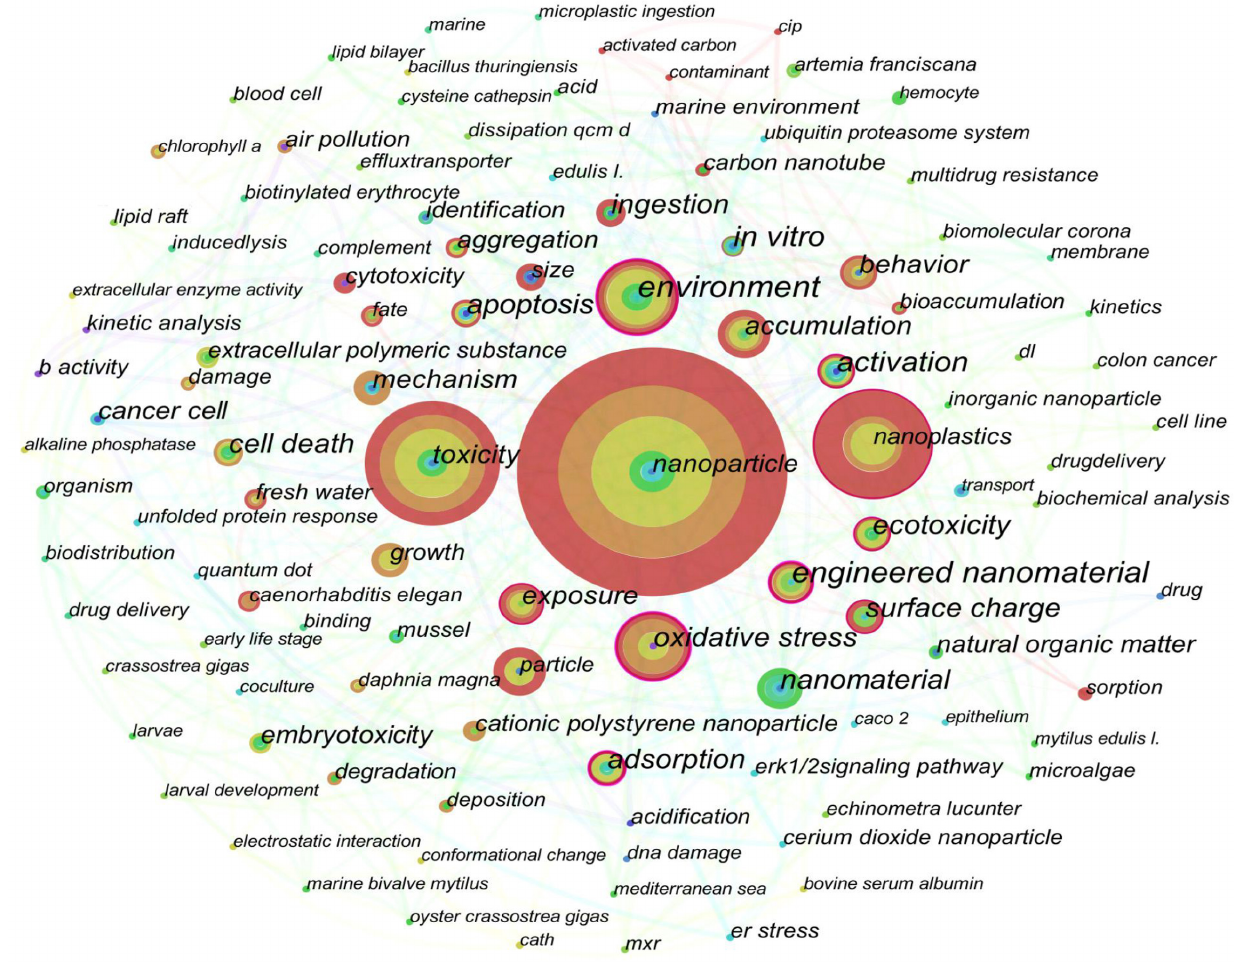
FIGURE 2 | Co-occurrence network of keywords extracted from the obtained literature. The size of each node represents the occurrence frequency of the corresponding